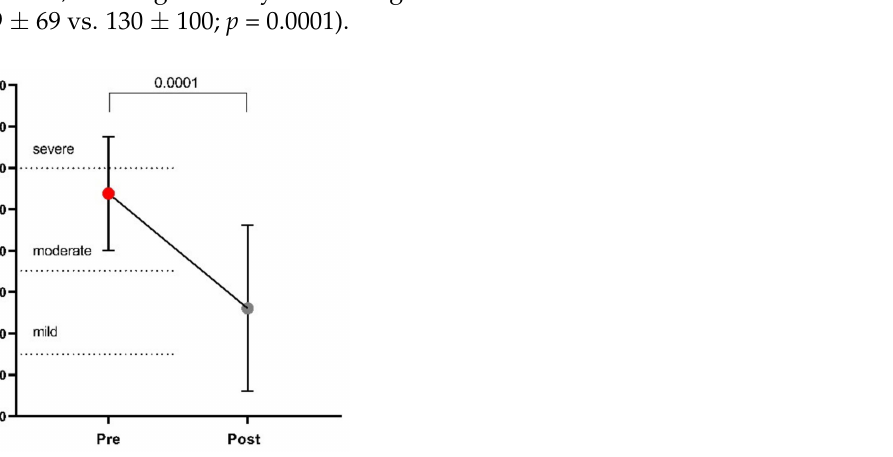
Figure 1. The IBS Severity Scoring System (IBS-SSS) total score before and after low FODMAPs diet. Data are presented as mean ± SD. Statistical analysis: Wilcoxon matched-pairs signed-rank test with a significant difference set at p <